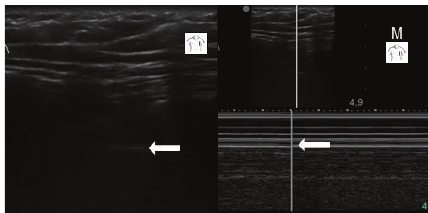
Figure 3: Case 2 : B-mode and M-mode sonography using a linear transducer positioned in the mid-clavicular line at the 3rd right intercostal space (B: B-mode, M: